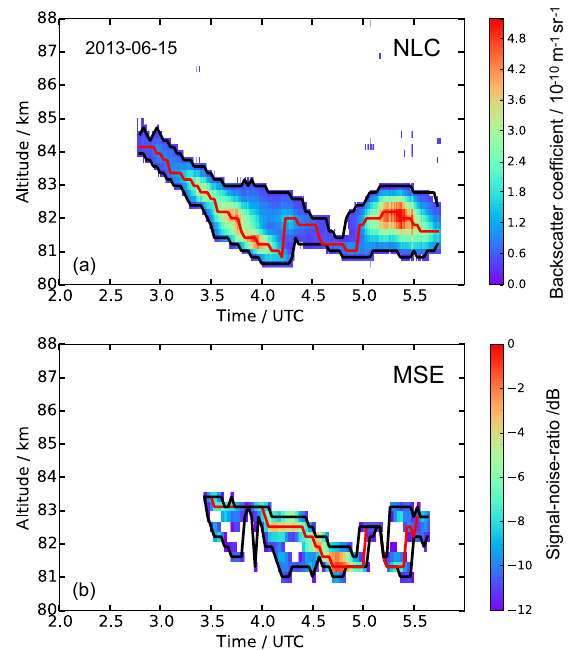
Figure 1. Examples of detection of NLCs (a) and MSEs (b) us- ing observations on 15 June 2013. The black lines show the up- per and lower edges ( z low and z up ), the red line the layer maxima ( z max ). Edge detection is done on the temporal resolution of the radar (2min). Edges are defined at β = 0 . 3 (NLC) and the SNR is − 12dB